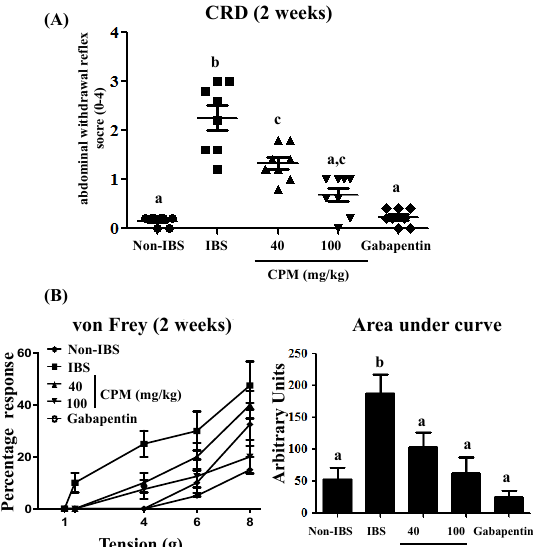
Figure 2. ( A ) Response to colorectal distension (CRD) of 60 mmHg with a balloon catheter (duration = 20 s, interstimulus interval = 5 min) two weeks after DCA intracolonic administration in rats treated with calcium pyruvate monohydrate (CPM) (40 mg/kg and 100 mg/kg) or gabapentin (70 mg/kg). ( B ) Evaluation of referred hyperalgesia two weeks after DCA administration induced by von Frey filaments (1–8 g) applied to the lower back (five times for 10 s) in rats treated with CPM (40 mg/kg and 100 mg/kg) or Gabapentin (70 mg/kg). Referred hyperalgesia was measured by percentage of response to von Frey filaments and the area under the curve (AUC) was calculated. Data are expressed as means ± SEM ( n = 8). Groups with different letters statistically differ ( p < 0.05).